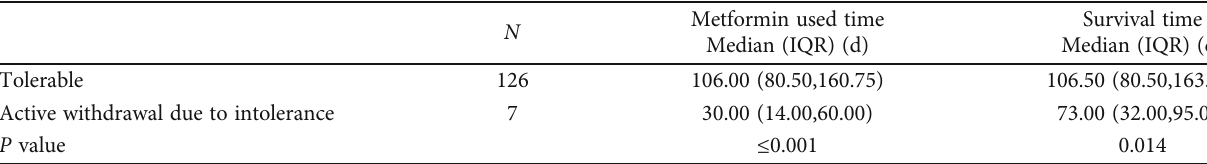
Table 5: Complications during metformin use in the study